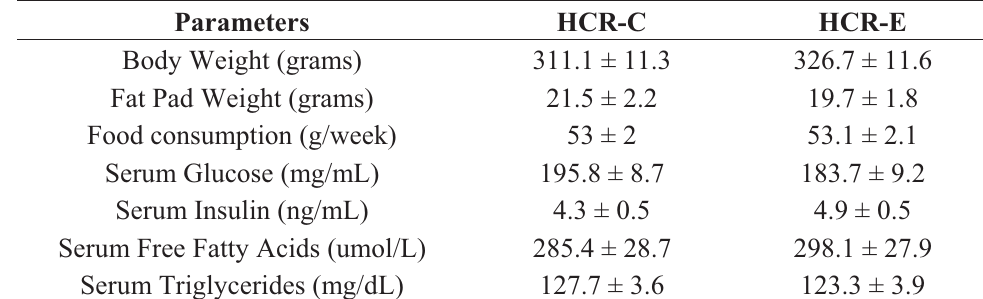
Table 1. Animal Characteristics. No significant differences were noted between the HCR-C (high capacity runner-control) and HCR-E (high capacity runner-ethanol)